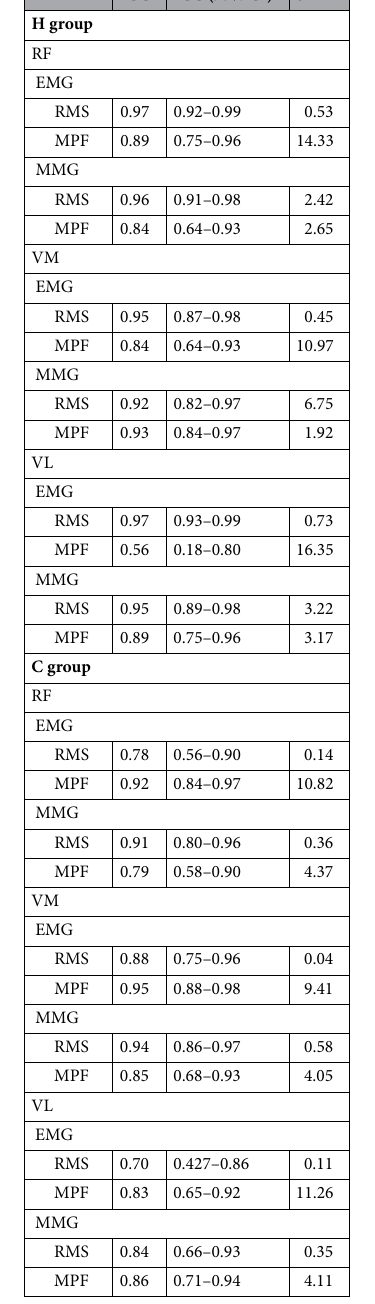
Table 5. ICC and SEM of maximal tendon reflex for each parameter. Data of SEM are shown as mV for EMGRMS, µm for MMGRMS, and Hz for EMGMPF and MMGMPF. ICC interclass correlation, SEM standard error of measurement, CI confidence interval, RF rectus femoris, VM vastus medialis, VL vastus lateralis, EMG electromyography, MMG mechanomyography, RMS root mean square, MPF mean power